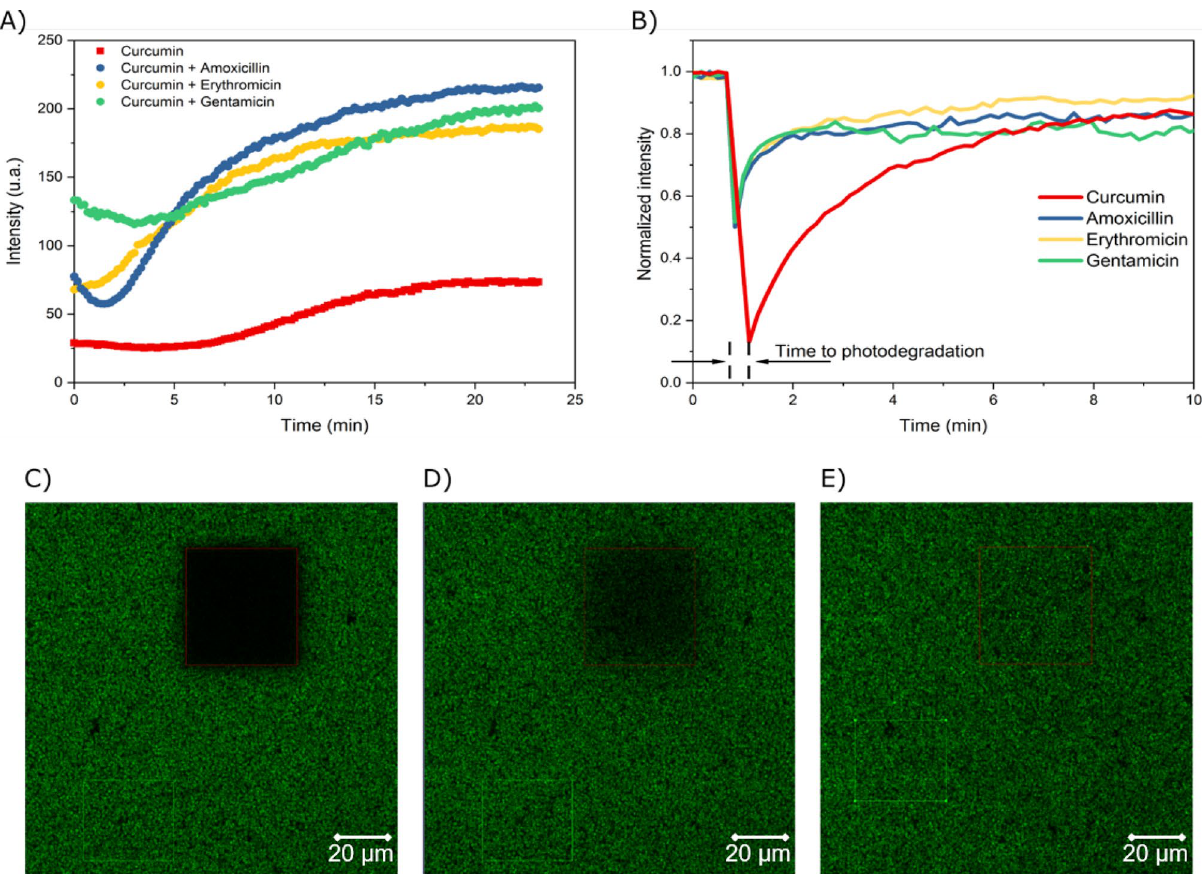
Figure 3. Confocal microscopy data of 10 μM curcumin fluorescence in S. aureus and in the presence of amoxicillin, erythromycin, and gentamicin. ( A ) Kinetics of curcumin incorporation. ( B ) Fluorescence Recovery After Photodegradation (FRAP) of curcumin. Image of photodegradation of internalized curcumin with 63 × magnification and channel mode with ( C ) 1min7s D) 2min7s and ( E ) 10min1s